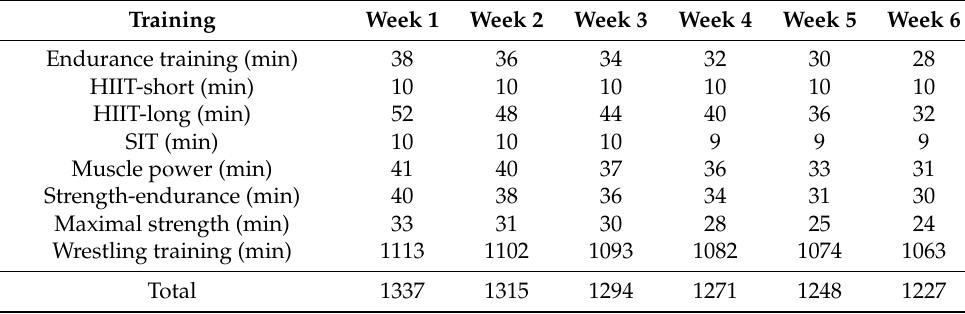
Table 1. Volume (min) of training during each week.